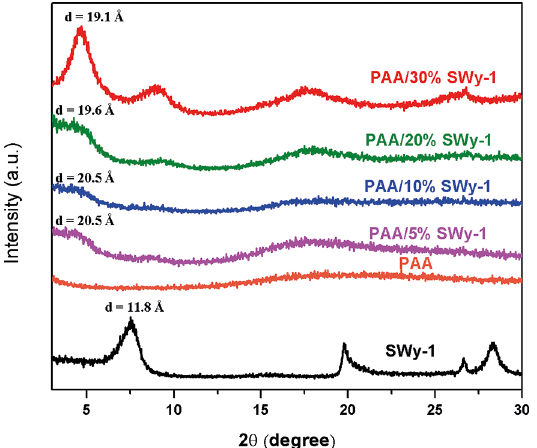
Figure 2. X-ray diffraction for SWy-1 clay, PAA and nanocomposite films. On the other hand, the 001 reflection peak for PAA/30%SWy-1 has been shifted toward lower angles, which is an indication of the lower regularity and large basal spacing as a result of the intercalation of PAA chains into the clay galleries 26 .